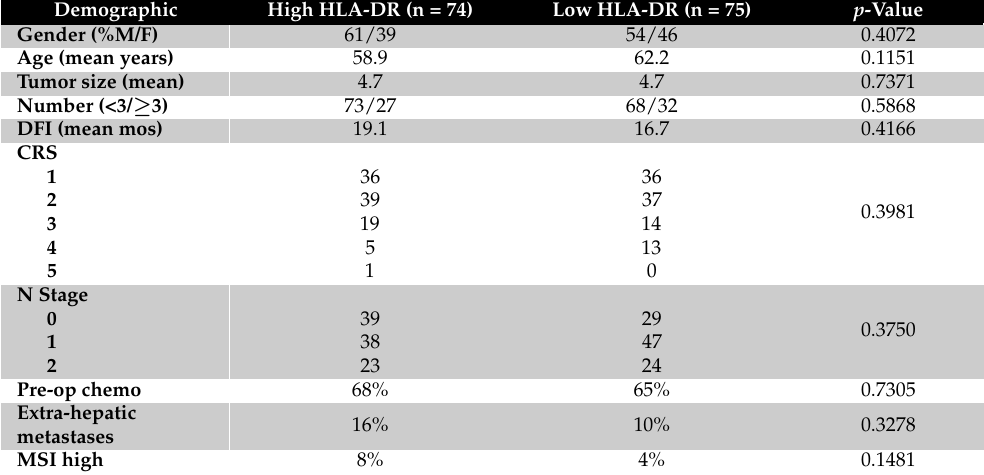
Table 1. Demographic data on patients with high and low HLA-DR-expressing